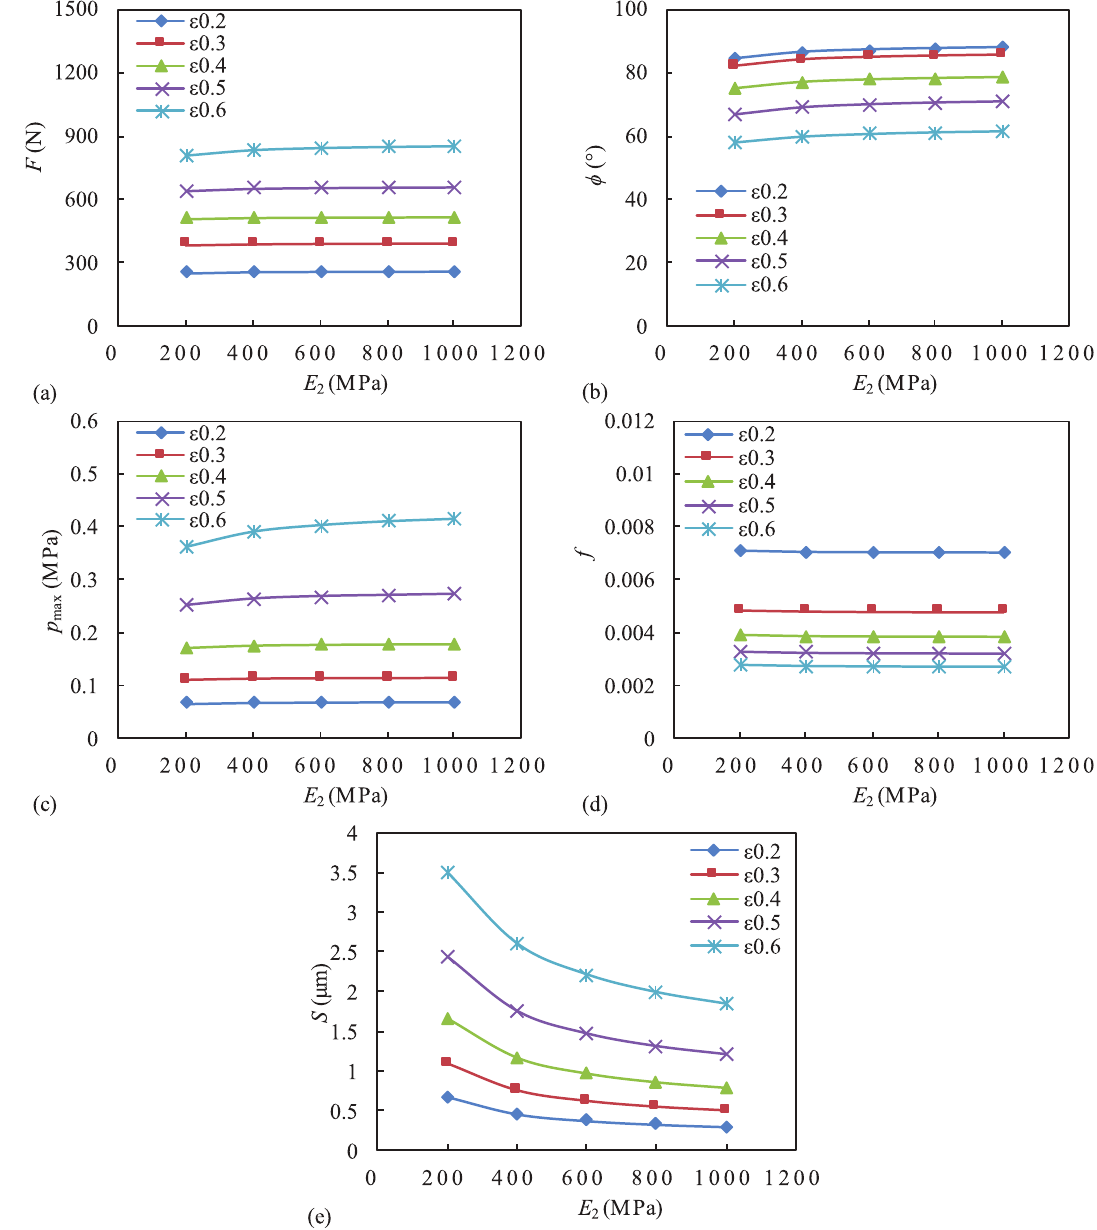
Fig. 13. Effect of low elastic under-layer bush elastic modulus on the lubrication performance of double-layer bearing (a) Load carrying capacity, (b) Attitude angle, (c) Maximum water fi lm pressure, (d) Friction coef fi cient, (e) Maximum bearing bush deformation, for N = 1500 rpm, t1 = t2 = 5 mm, E1 = 1000 MPa, n1 = 0.4, n2 =